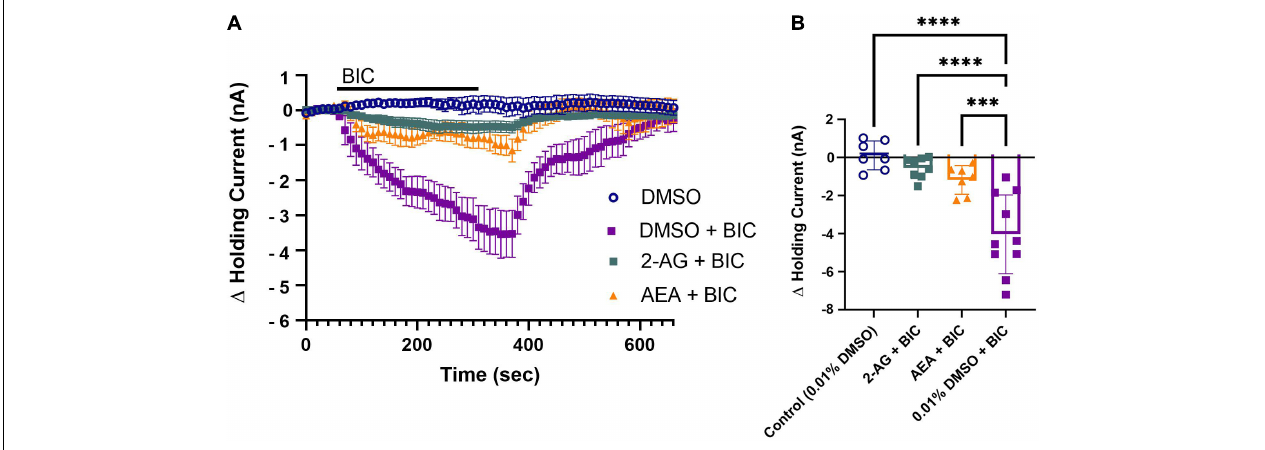
FIGURE 3 | 2-AG and AEA depress tonic inhibition in the P cell. (A) 30 min following pretreatment with 2-AG (2-AG+BIC) or AEA (AEA+BIC) produced only a very small change in holding current, indicating depression of tonic GABAergic input. (B) In terms of the peak change in holding current, both the 2-AG + BIC and AEA + BIC groups were significantly reduced compared to the DMSO + BIC ( ∗∗∗ indicates p < 0.001; ∗∗∗∗ indicates p < 0.0001). The DMSO + BIC group was also significantly different from the DMSO group. The 2-AG + BIC and AEA + BIC groups were not significantly different from the DMSO group. All data is shown as mean ±